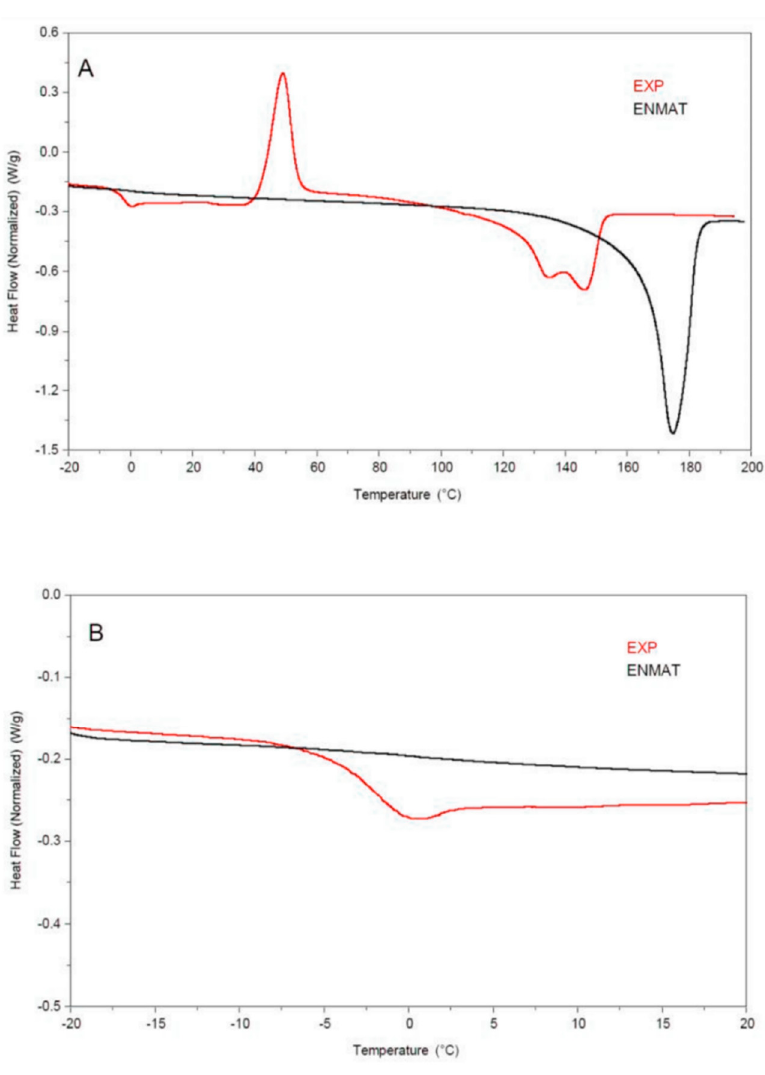
Figure 4. DSC thermograms ( − 20–200 °C, panel A ; − 20–20 °C, panel B ) obtained from the second heating of the PHBV purified from R-NF fermented with Haloferax mediterranei DSM1411 (EXP) and the commercial reference ENMAT™ Y1000P (ENMAT).